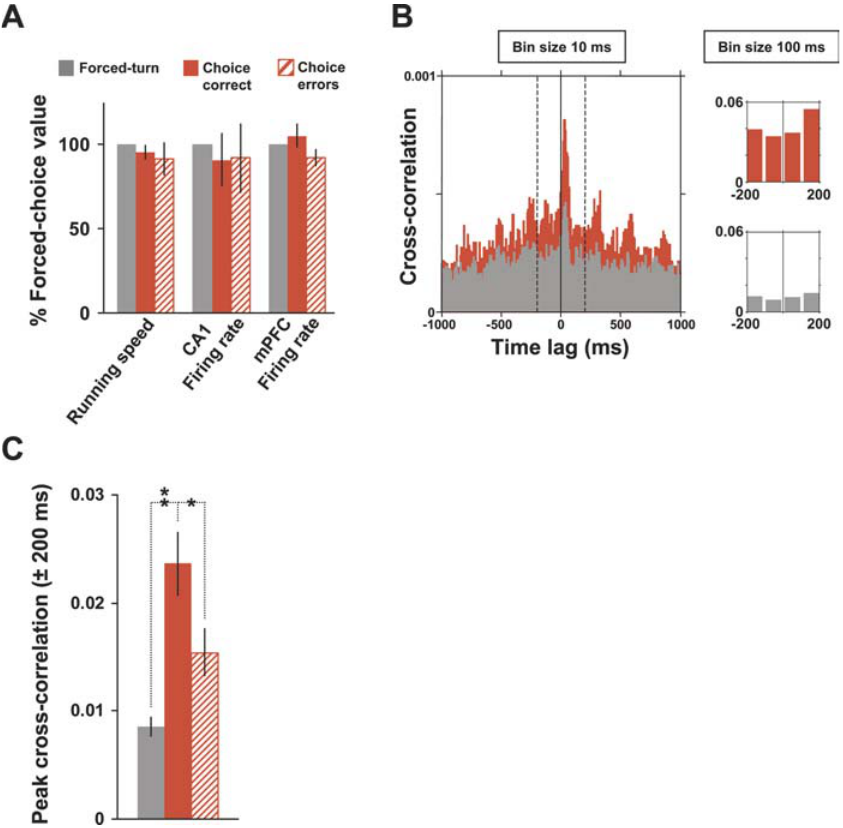
Figure 4. Enhanced Cross-Correlations between Spike Trains of CA1–mPFC Neuron Pairs during Behavioral Epochs Requiring Working Memory and Decision-Making (A) Mean running speeds, CA1 firing rates, and mPFC firing rates were comparable during forced-turn (grey, epoch 5), choice-correct (red, epoch 2), and choice-error runs (hatched red) across the central arm. (B) Example cross-correlogram (bin size 10 ms, maximum time lag 6 1,000 ms) for a single CA1–mPFC neuron pair (referenced to the CA1 firing at time 0), showing that correlated activity was higher during choice runs (red) than forced-turn runs (grey). The width of the central peak at 50% of its maximum value is 120 ms. This compares with a mean peak width of 156 6 41 ms for 29 neuron pairs with peak cross-correlation coefficients (bin size 10 ms) of at least 0.0005. For comparison across task epochs, peak cross-correlation coefficients were quantified at the 6 200-ms time range with a bin size of 100 ms (inset to the right). (C) Mean correlations for all neuron pairs that fired at least 50 spikes each during the three run types. CA1–mPFC correlation coefficients were significantly higher during choice runs (72 pairs) than during forced-turn (72) or error runs (49 pairs; ** p , 0.01, * p , 0.05 Wilcoxon rank sum test for grouped animal means). DOI: